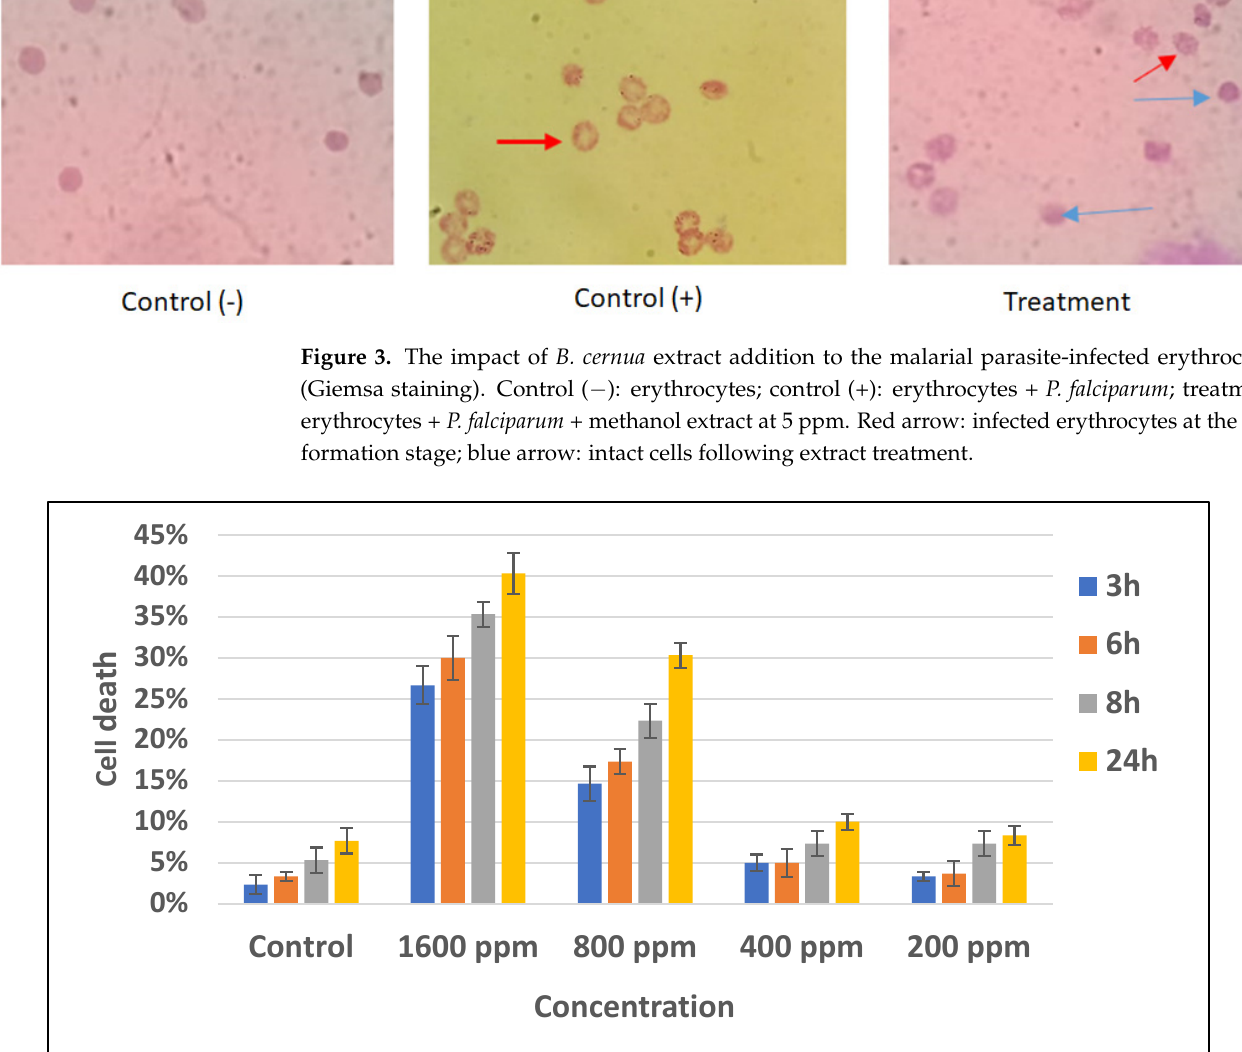
Figure 3. The impact of B. cernua extract addition to the malarial parasite ‐ infected erythrocytes (Giemsa staining). Control ( − ): erythrocytes; control (+): erythrocytes + P. falciparum ; treatment: erythrocytes + P. falciparum + methanol extract at 5 ppm. Red arrow: infected erythrocytes at the ring formation stage; blue arrow: intact cells following extract treatment.